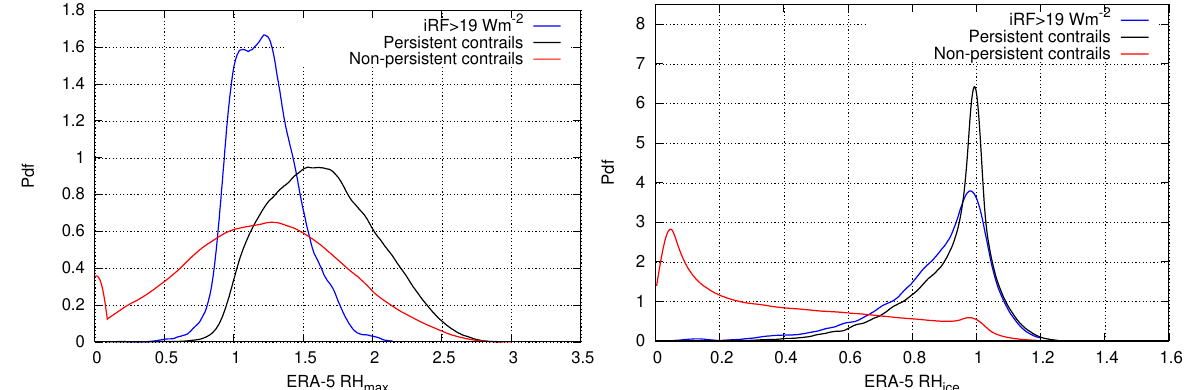
Figure 3. As Figure 1, but for RH max ( left panel) and RH i ( right